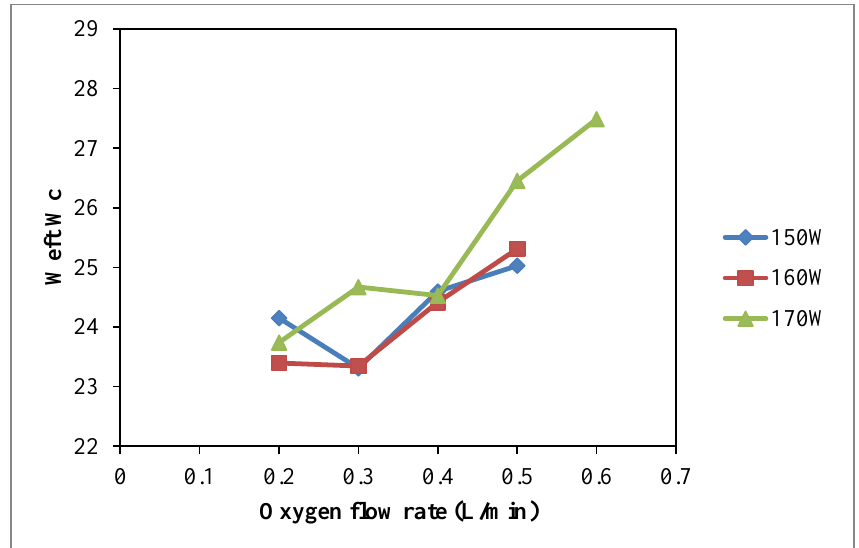
Figure 7. Effect of oxygen flow rate on weft W c (Oxygen flow rate: 0.2 L/min, 0.3 L/min, 0.4 L/min, 0.5 L/min and 0.6 L/min; Discharge power: 150 W, 160 W and 170 W; Jet travelling speed: 5 mm/s and Jet-to-substrate distance: 3